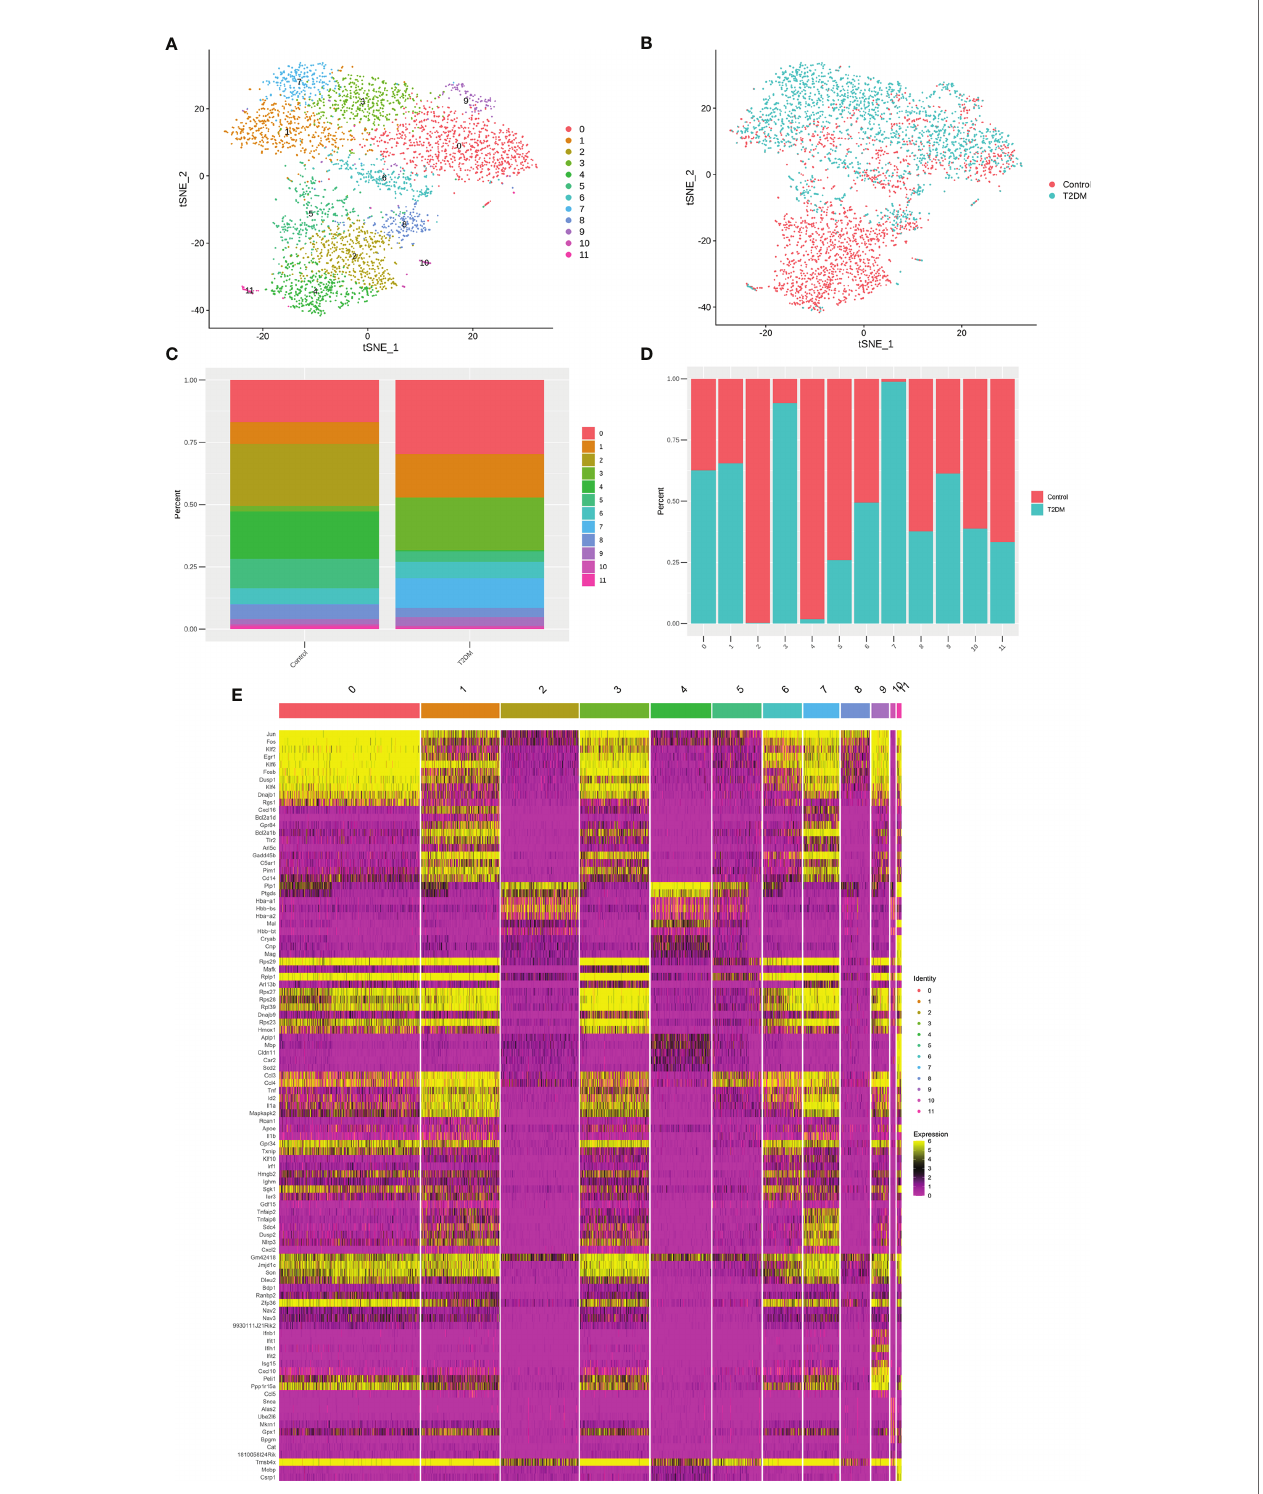
FIGURE 7 | Subclustering of microglial cells. (A) t-SNE plot showing microglial cells subclusters. (B) t-SNE plot of microglial cell, colour coded according to genotype. (C) Percentage of cells in each microglial cell cluster. (D) Cell cluster percentages across two experimental groups (db/db and db/m). (E) The heatmap showing the expression levels of speci fi c genes in microglial cells